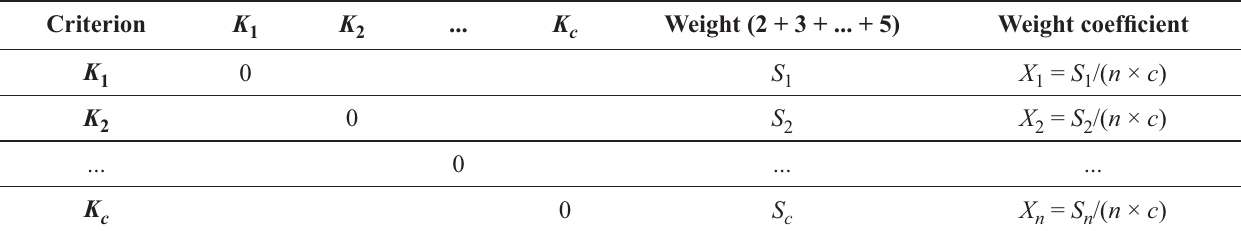
Table 2. Comparison of criteria